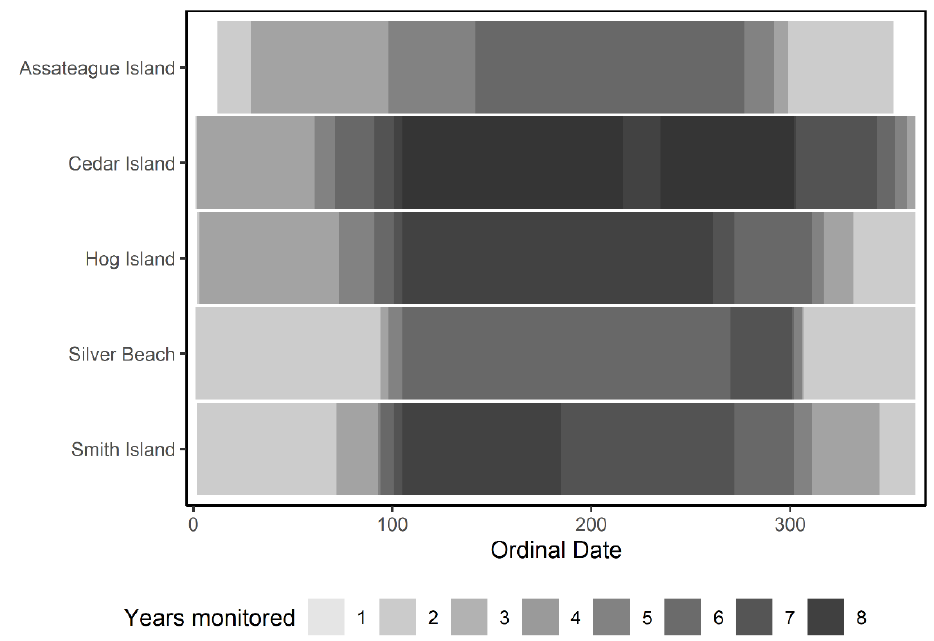
Figure 3. Site specific acoustic recording effort by ordinal date (day of the year). Effort (number of years monitored) is indicated as a heatmap of site vs. ordinal date such that lighter shades indicate lower effort (min = 1 year) and darker shades indicate higher effort (max = 8 years). Monitoring was